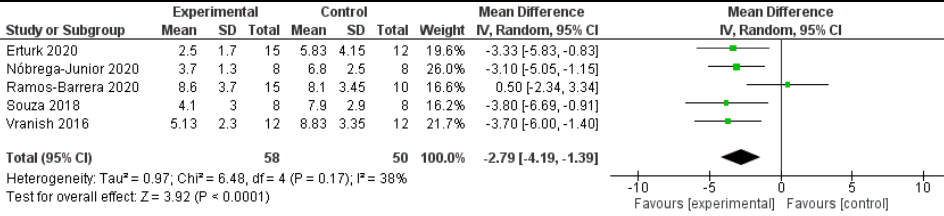
Figure 6. Forest plot for Pittsburgh sleep quality index.